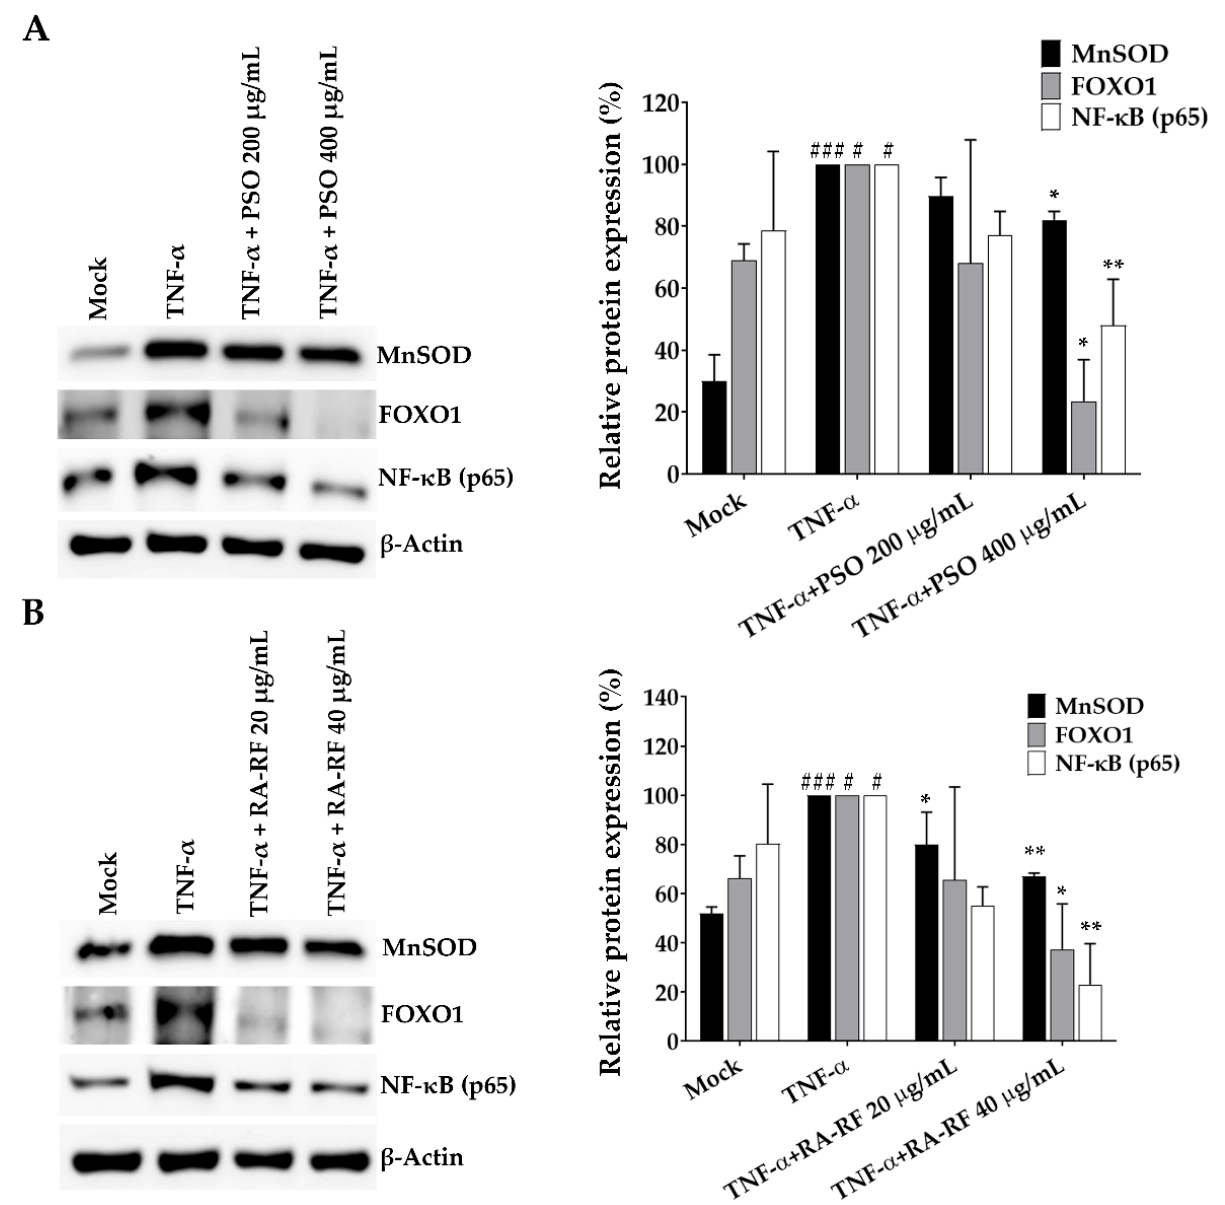
Figure 8. Treatment with PSO ( A ) and RA-RF ( B ) reduced the expression of NF- κ B, FOXO1, and MnSOD proteins. A549 cells were pretreated with PSO and RA-RF for 2 h before incubation with TNF- α for 24 h. The cell lysates were analyzed by Western blotting with anti-NF- κ B, anti-FOXO1, and anti-MnSOD antibodies. All assays were performed in triplicate; data are presented as mean ± standard deviation ( # p < 0.05, ### p < 0.001 vs. the control group; * p < 0.05, ** p < 0.01, vs. (+) TNF- α induced group).